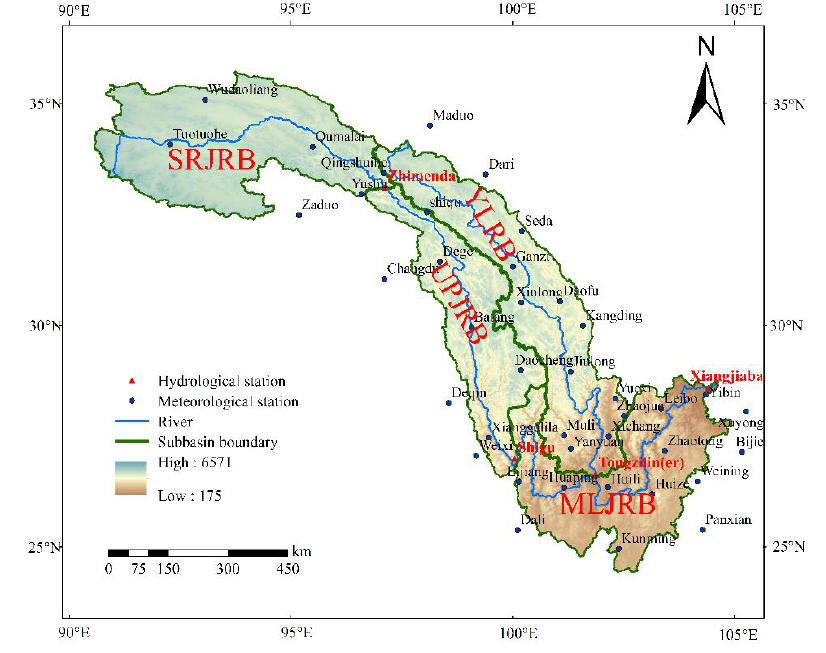
Figure 1. Location of the Jinsha River Basin (JRB), China, along with meteorological stations, topographical gradients, and sub-basin boundaries.